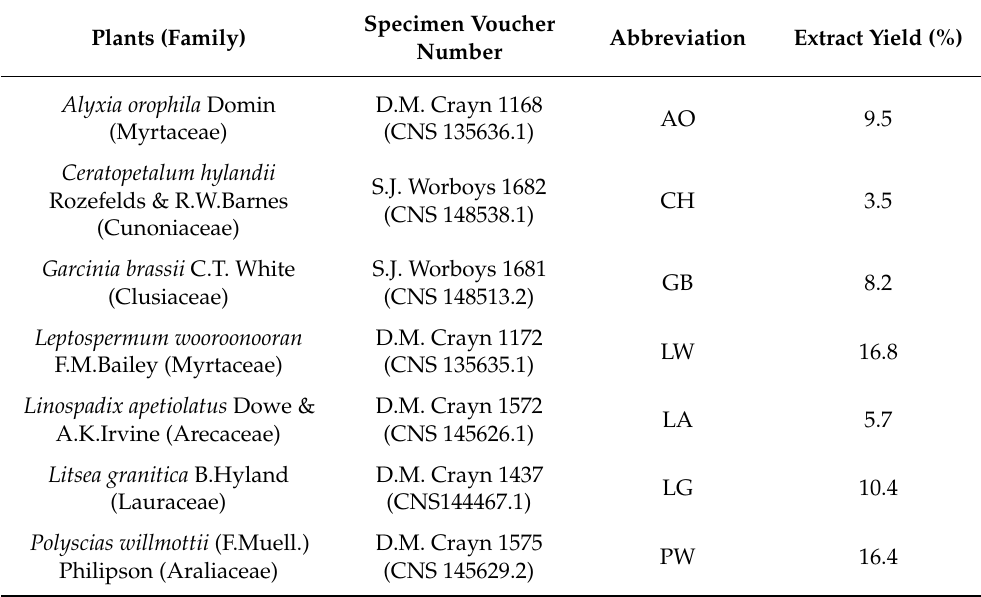
Table 1. Voucher specimen numbers of the seven Wet Tropics plants and their percentage yield of crude extracts.